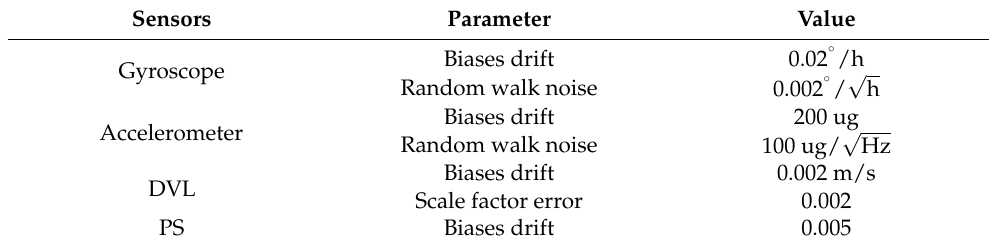
Table 1. Main performance parameters of the sensors.